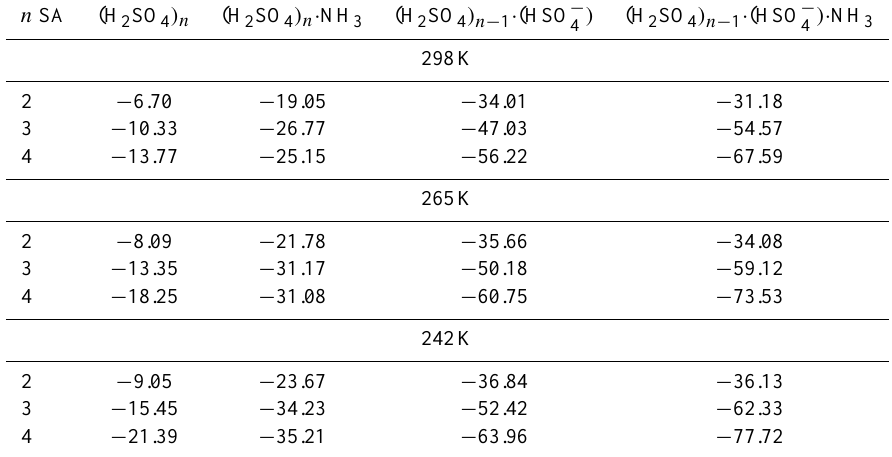
Table 2. The Gibbs formation free energies (relative to free molecules with reference partial pressure 1atm) in units of kcal/mol at 298, 265 and 242K are listed as a function of the number of total sulfuric acid molecules and hydrogensulfate ions in the clusters.